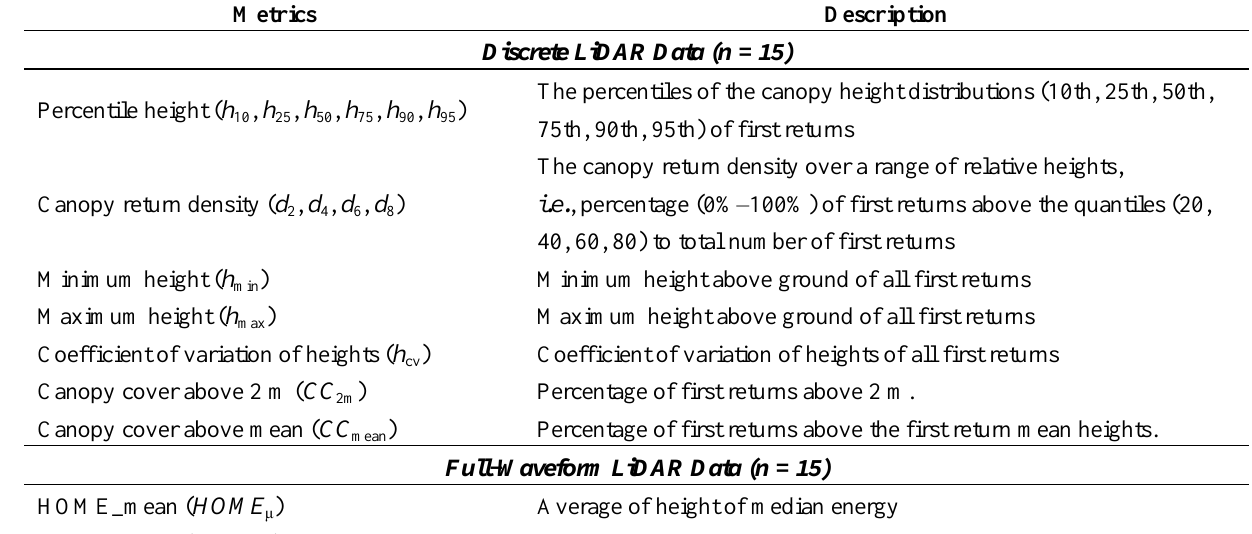
Table 2. Summary of LiDAR metrics computed from discrete and full-waveform LiDAR data. Metrics Description